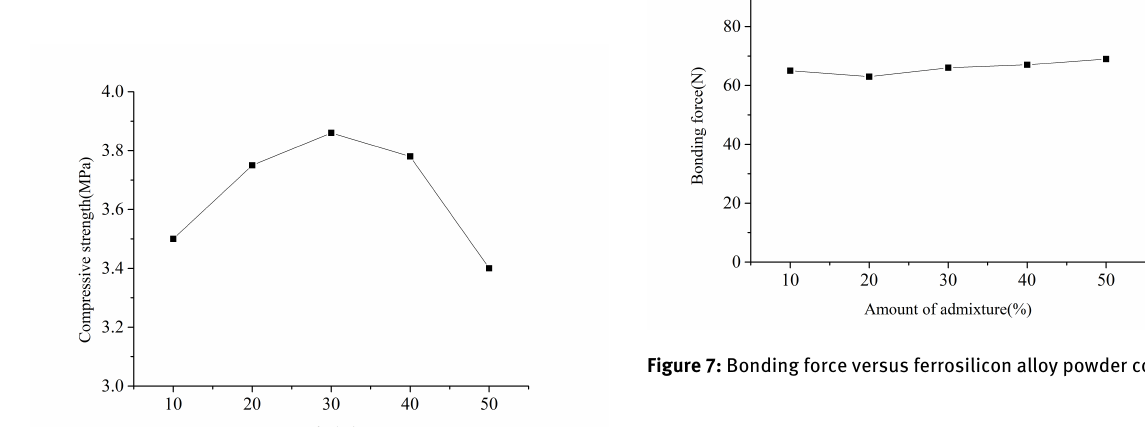
Figure 7: Bonding force versus ferrosilicon alloy powder